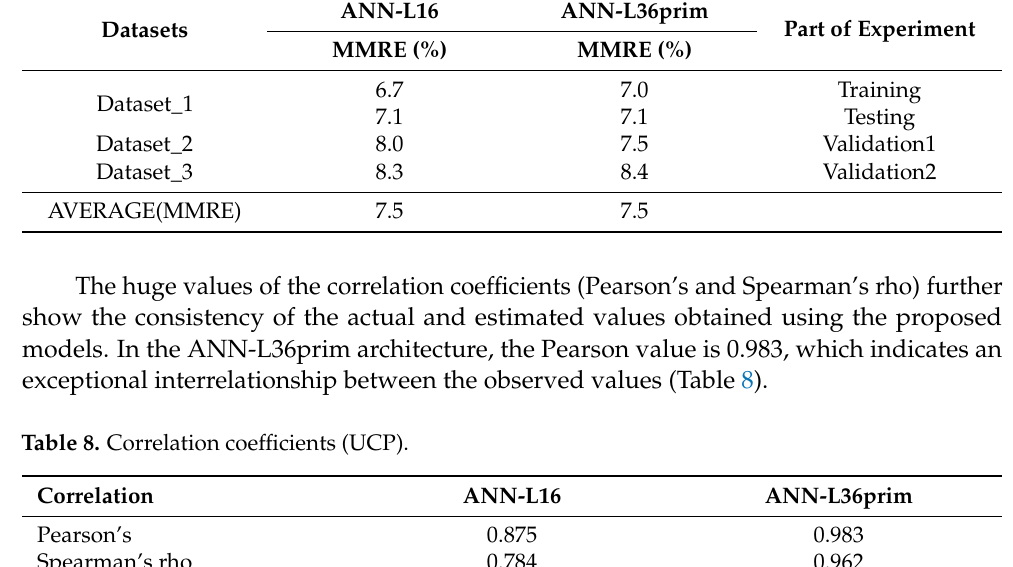
Prediction represents the number of projects that have an error less than the set criterion. Prediction can further confirm the validity and reliability of the models used. For all three proposed criteria (PRED (25), PRED (30), and PRED (50)) and in all three parts of the experiment, using both proposed architectures, the value is 100% (Table